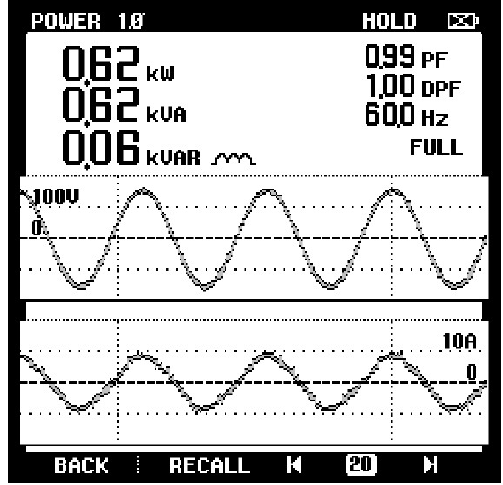
Figure 14. Power factor of the CC.